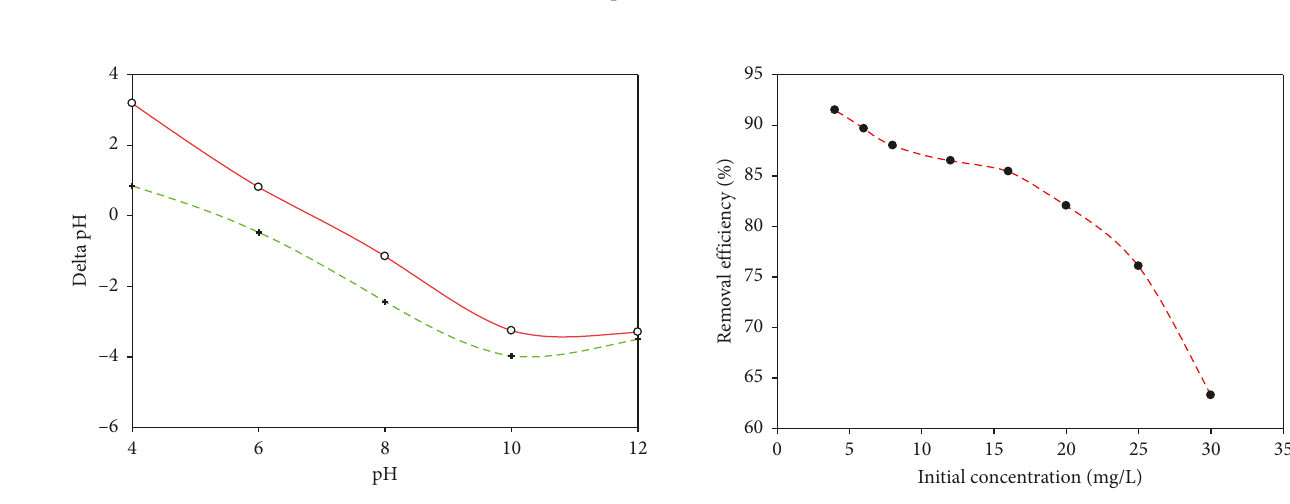
Figure 3: EDX spectra of RB (a) and FMBC (b).